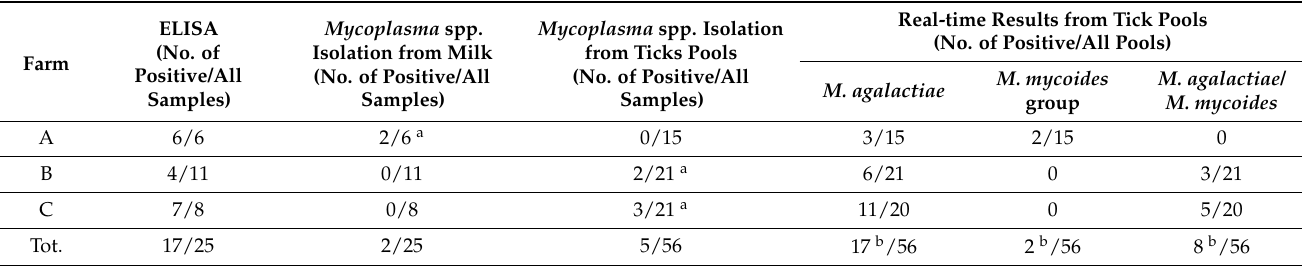
Table 3. Mycoplasma identifications from the ticks and hosts sampled on the three farms comparing ELISA, cultural isolation, and PCR